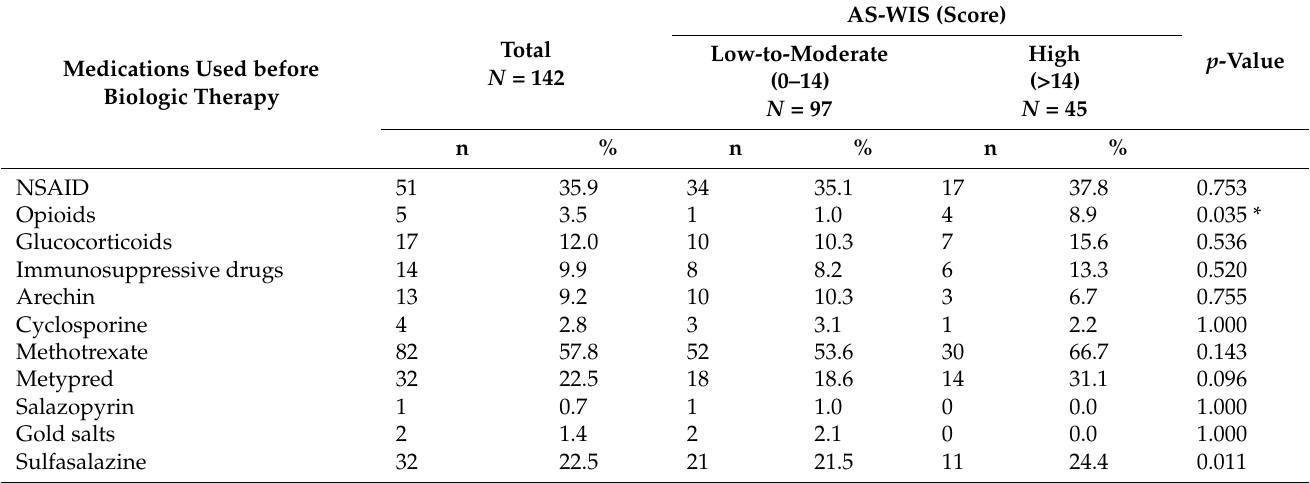
Table 5. The clinical characteristics of RA patients divided into two groups depending on the level of risk of work disability.